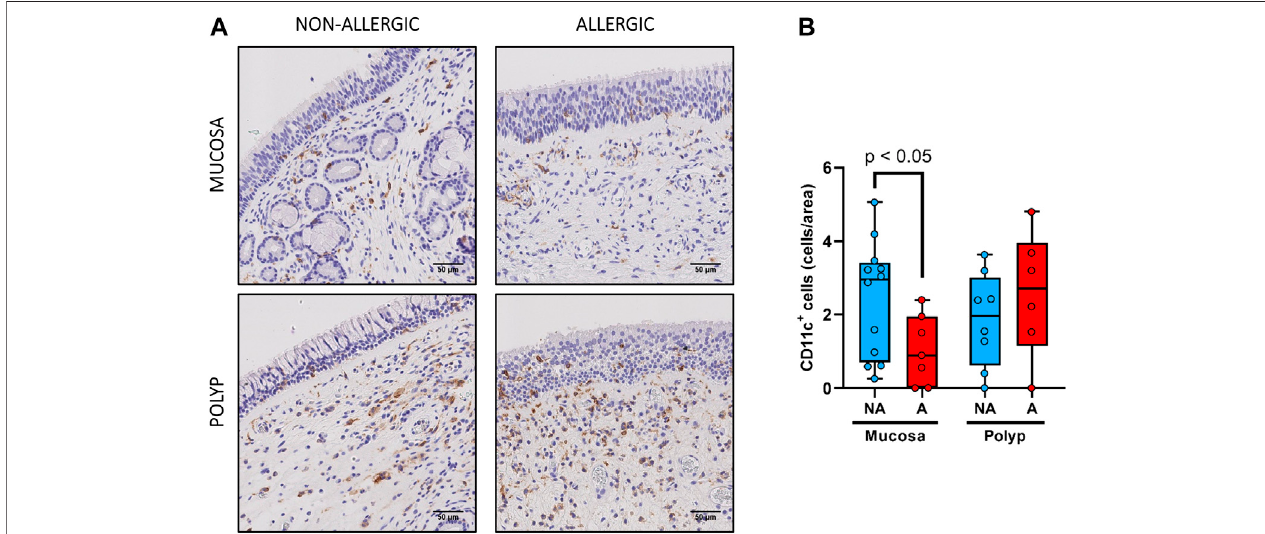
FIGURE 9 | Analysis of CD11c + cells in fi ltrates in nasal polyps and nasal mucosa. (A). Representative images of anti-CD11c immunostaining in nasal mucosa ( n (cid:2) 19)andnasalpolyps( n (cid:2) 14)inallexperimentalgroups(CD11c + cells:blackarrow → ,scalebar (cid:2) 50 μ m). (B). ComparisonofthenumberofCD11c + cellsperareain nasalpolypsandnasalmucosasamplesbetweennon-allergicCRSwNP(NA)andallergicCRSwNP(A)patients.Resultsarepresentedasmean ± SEM.Mann-Whitney U test was used to state signi fi cant